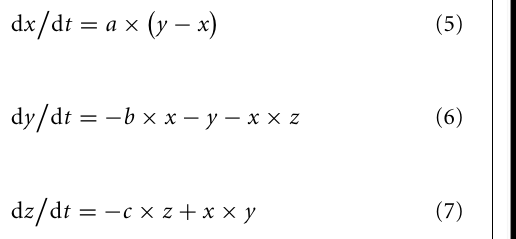
three ordinary differential equations using standard fourth-order Runge–Kutta estimations. Initial conditions can be set as vari- ables x = y = z = 0.1 using fixed parameters a = 10, b = 28, and c = 8/3. The first points of the three-dimensional trajectory